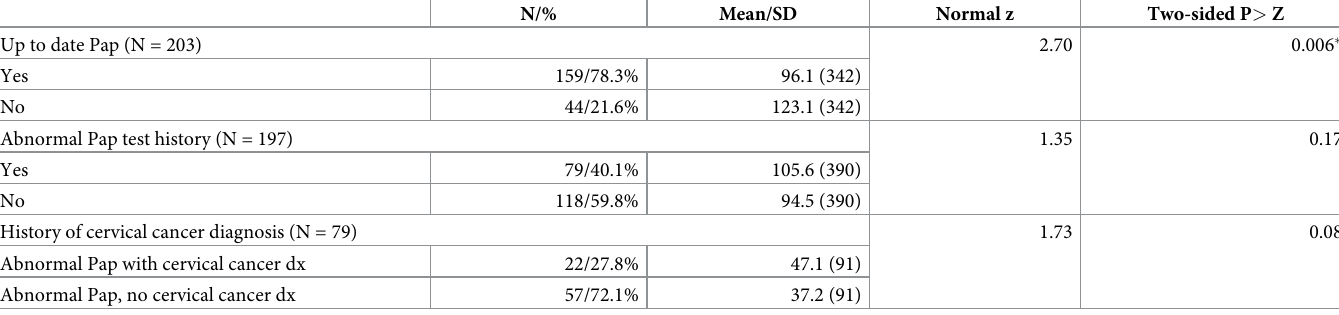
Table 2. Relationships between cervical cancer screening beliefs and dependent variables using Wilcoxon signed-rank tests a